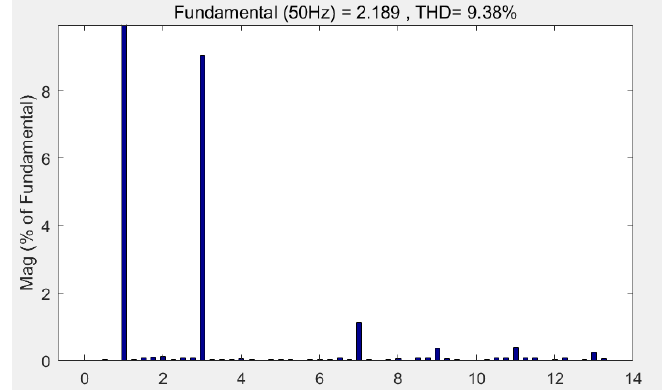
Figure 31. Harmonic characteristics based on the proposed dynamic modulation algorithm at m = 1.1.